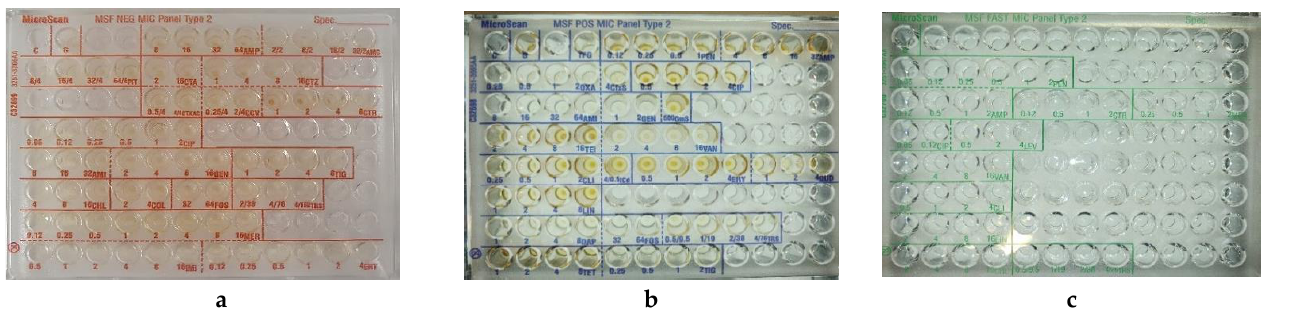
Figure 1. Example of the three MSF MicroScan MIC panels. ( a ) MicroScan MSF dried overnight Gram-positive panel, ( b ) MicroScan MSF dried overnight Gram-negative panel, ( c ) MSF dried overnight fastidious panel.